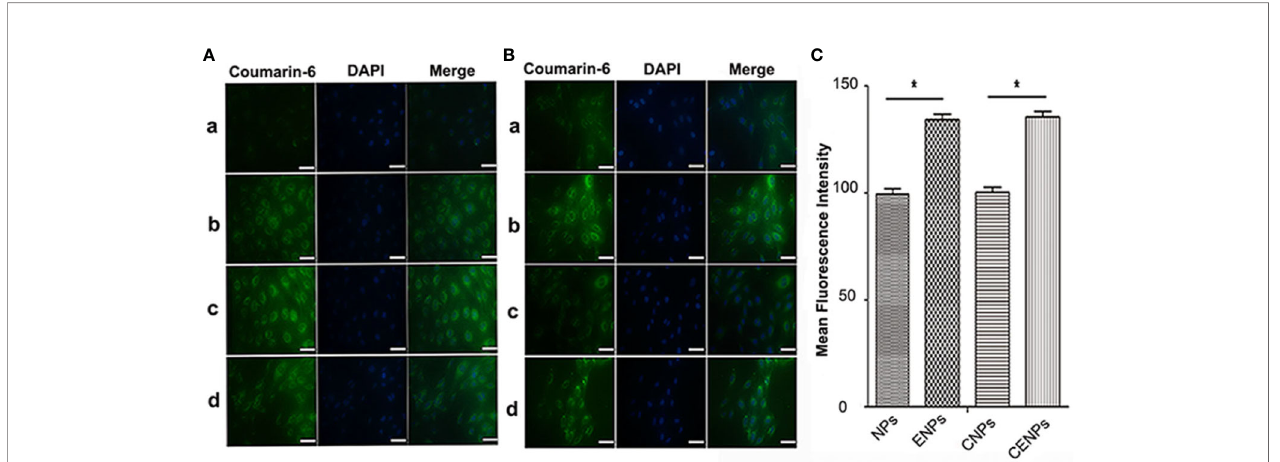
FIGURE 2 | In vitro uptake of nanoparticles by HUVECs. (A) Time trend of nanoparticle uptake by HUVECs. a. 1 h; b. 3 h; c. 6 h; d. 10 h. (B) Uptake of coumarin- 6-labelled nanoparticles by HUVECs at 37°C for 6 h under microscopy. a. Coumarin-6-NPs; b. Coumarin-6-ENPs; c. Coumarin-6-CNPs; d. Coumarin-6-CENPs. Green: Coumarin-6-labelled nanoparticles; Blue: Nuclei. (scale bars 50 m m) (C) Uptake of coumarin-6-labelled nanoparticles was investigated by fl ow cytometry. Data are expressed as the mean ± SD (n = 3); *p < 0.05, compared with the control group.